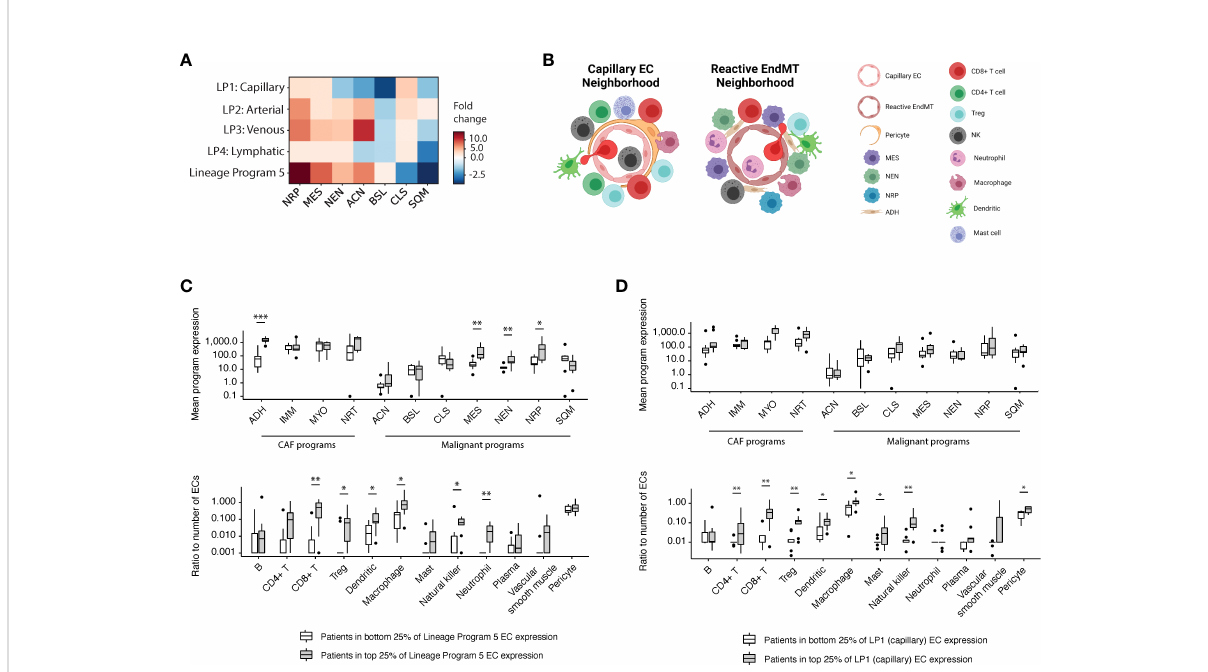
FIGURE 3 Reactive EndMT endothelial cells are associated with malignant cells expressing neural-like progenitor, mesenchymal, and neuroendocrine-like programs. (A) Fold change (color bar) of malignant programs (columns) between top quartile versus bottom quartile scoring patients for endothelial lineage programs (rows). (B) Schematic of enriched malignant programs, cancer-associated fi broblast (CAF) programs, and diverse stromal/immune cell type populations in the tumor microenvironment surrounding Lineage Programs 1 (capillary; left) and 5 (reactive EndMT; right) endothelial cells. (C, D) Top: Mean expression of CAF and malignant programs between top quartile versus bottom quartile scoring patients for Lineage Program 5 (C) and Lineage Program 1 (capillary) (D) EC expression in the snRNA-seq data (7). Bottom: Ratio of the number of stromal/immune cell type (x axis) to endothelial cells between top quartile versus bottom quartile scoring patients for Lineage Program 5 (C) and Lineage Program 1 (capillary) (D) endothelial nuclei expression. *Benjamini – Hochberg-adjusted p value < 0.05, **p < 0.01, ***p < 0.001, FDR = 0.1, and two-sided Mann – Whitney U test. CAF programs: ADH, adhesive; IMM, immunomodulatory; MYO, myo fi broblast;